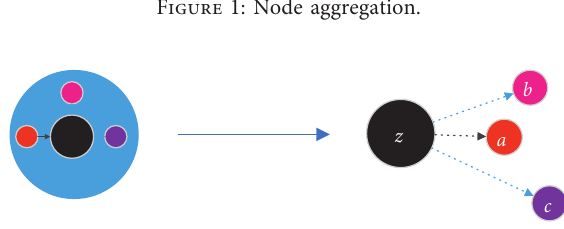
Figure 1: Node aggregation.